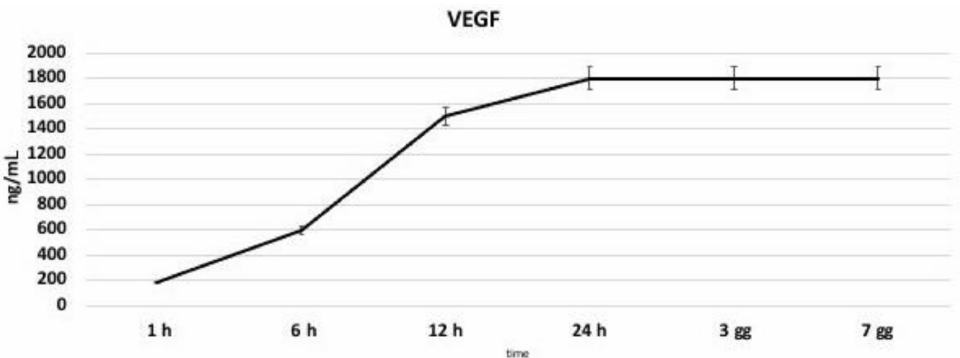
Figure 7. Quantification of Vascular Endothelial Growth Factor (VEGF) release in the cell culture medium. VEGF concentration increases in the medium in a time-dependent manner, reaching a plateau after 24